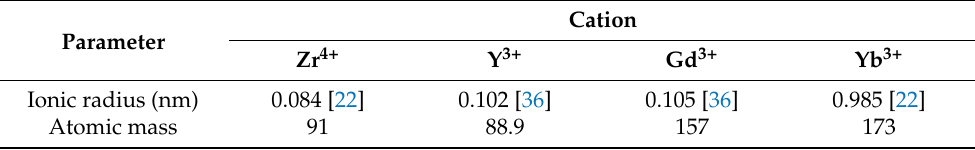
Table 2. Ionic radius and atomic mass of Zr 4+ , Y 3+ , Gd 3+ and Yb 3+ .